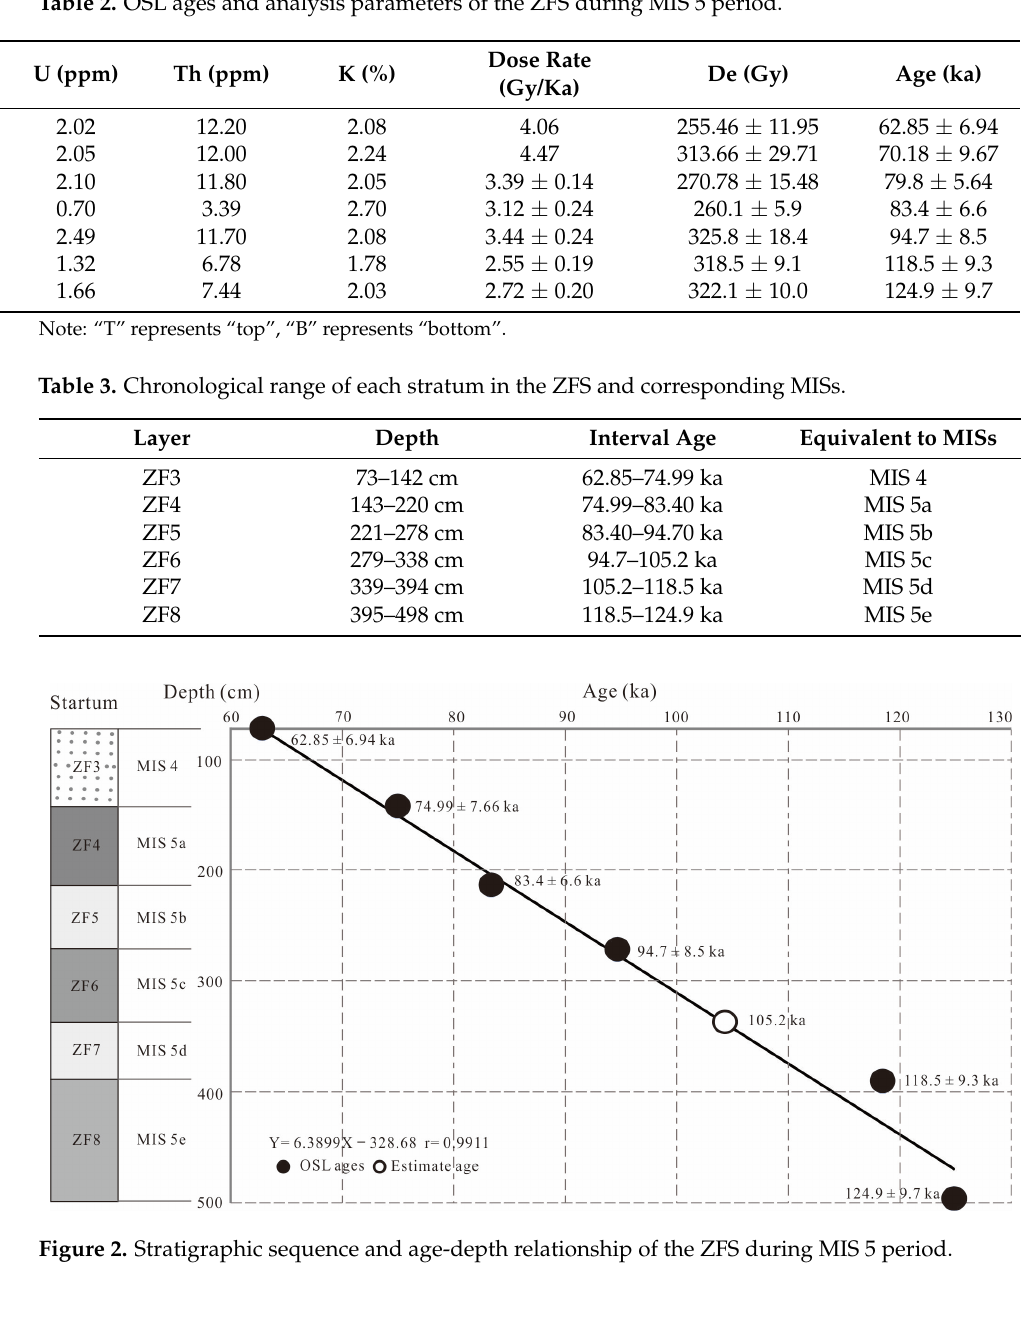
Table 2. OSL ages and analysis parameters of the ZFS during MIS 5 period.